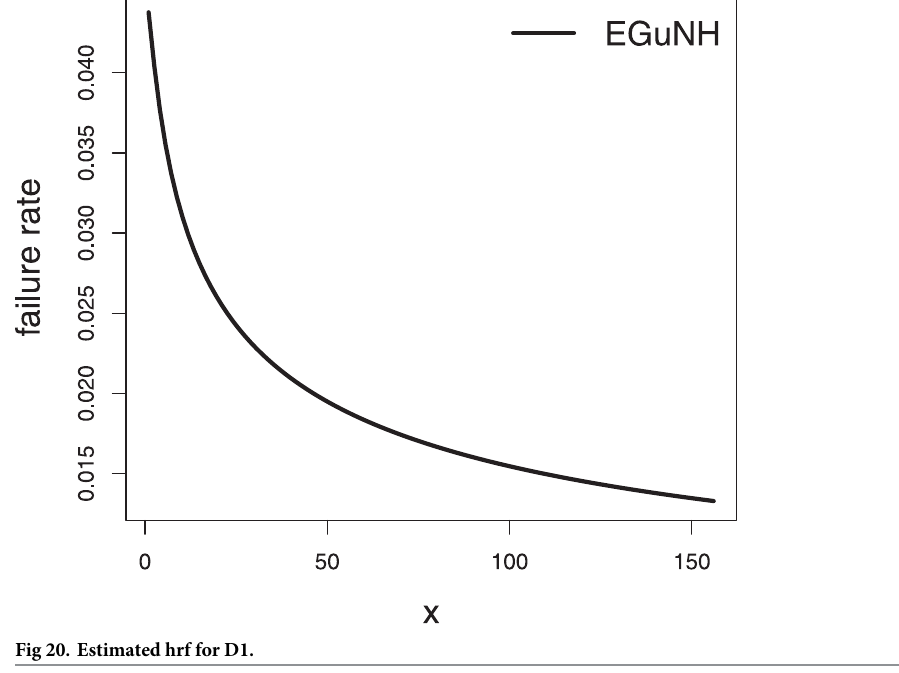
the results of the MLEs and their related standard errors (in parentheses) of the model parame- ters for the proposed model while the ICs are listed in Table 11 for the D1, D2 and D3, respec- tively. It is customary to supplement the analytical result defined in Tables 9 and 10, by displaying it graphically. Hence, the estimated pdfs Figs (23)–(25), PP–plots Figs (26)–(28),